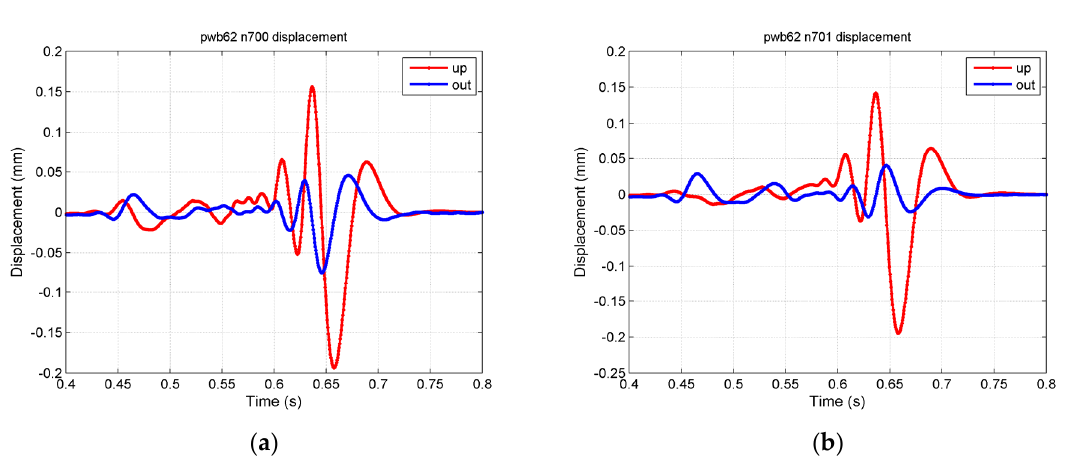
Figure 7. ( a ) A time series of motion at node 700; ( b ) Motion at node 701, 1 m below the seabed.